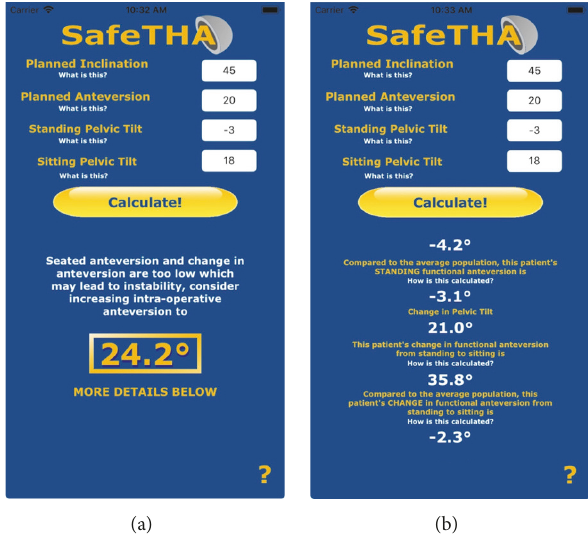
Figure 5: Screenshots of the “ SafeTHA ” app for Apple (cid:2) iOS mobile software that provides the user with calculated functional anteversions based on inputted desired planned inclination and anteversion, patient-specific measured standing, sitting, and change in, pelvic tilt using the mathematicalrelationship presented in this study. The averagepopulation-based functional anteversionsare also calculatedwith the same plannedcuppositionandequation.(a)Thefinaloutput(boxedyellownumber)istheresultantrecommendednewintra-operativeanteversion based on these calculations and the presented algorithm. (b) Additional specifics regarding patient’s anteversions compared to averages are also